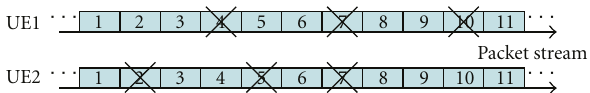
Figure 2: Multicast packet-loss pattern for 2